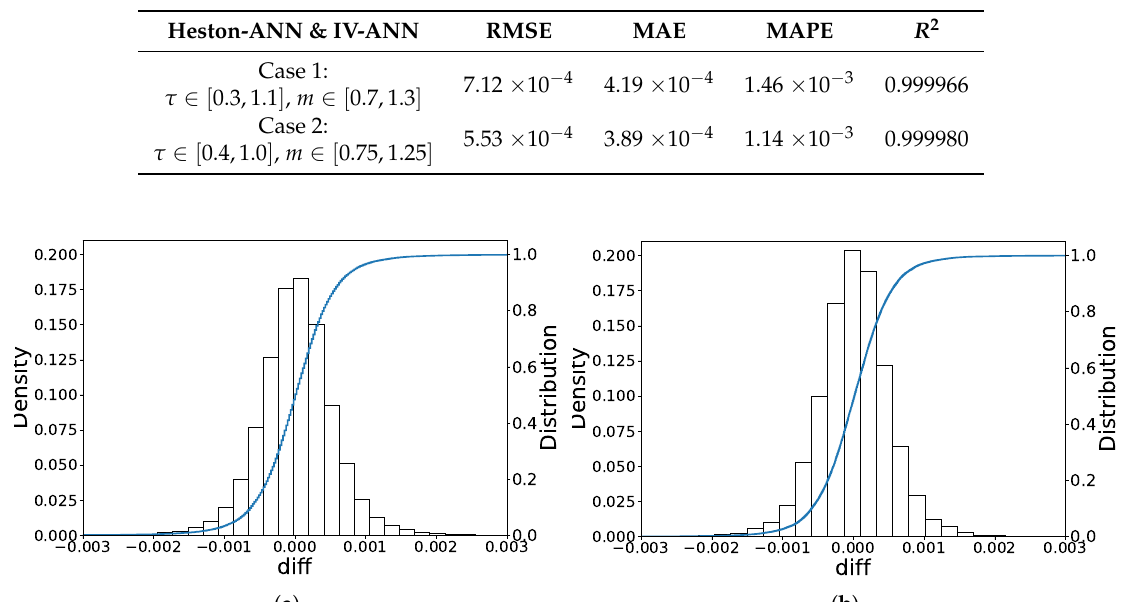
Table 11. Out-of-sample performance of the Heston-ANN plus the IV-ANN.